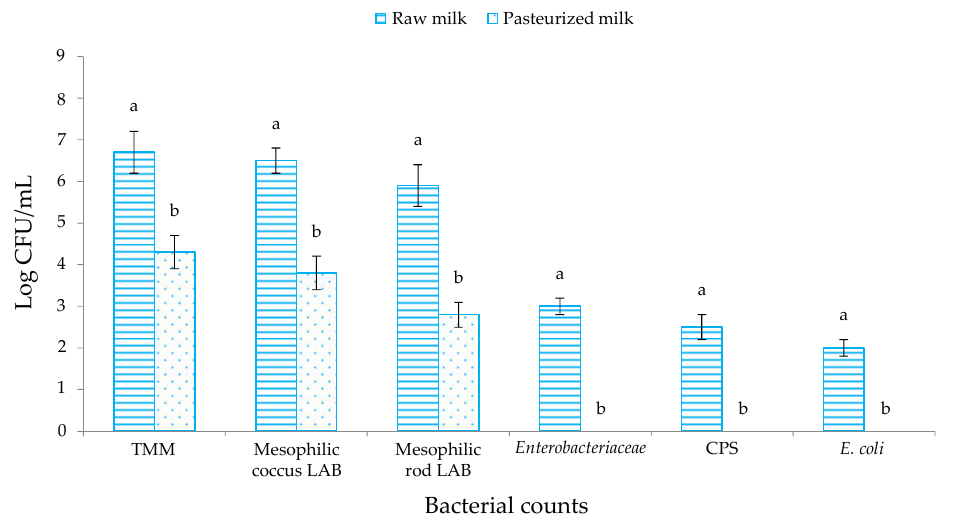
Figure 2. Microbial loads (Log CFU/mL) of raw and pasteurized milk samples. Abbreviations: TMM, total mesophilic microorganisms; CPS, coagulase-positive staphylococci; E ., Escherichia . Results indicate mean values and standard deviation of six determinations (carried out in duplicate for three independent productions). Different superscript letters indicate significant differences on microbial concentrations according to Duncan’s test between raw and pasteurized milk samples for p < 0.05.